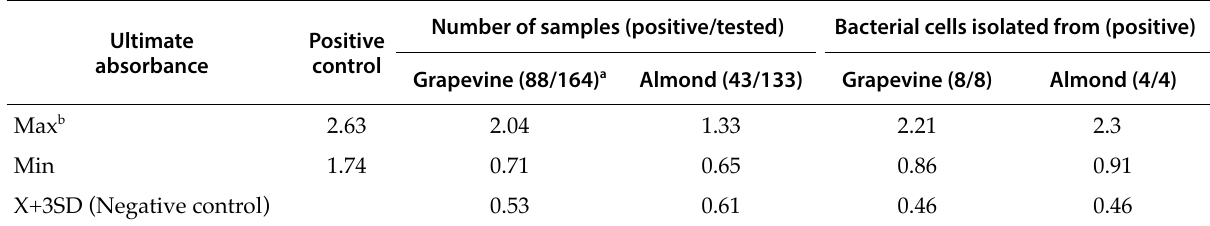
Table 2. Double antibody sandwich-enzyme-linked immunosorbent assay (DAS- ELISA) results for Xylella fastidiosa from grapevine and almond samples (absorbance at 630 nm).